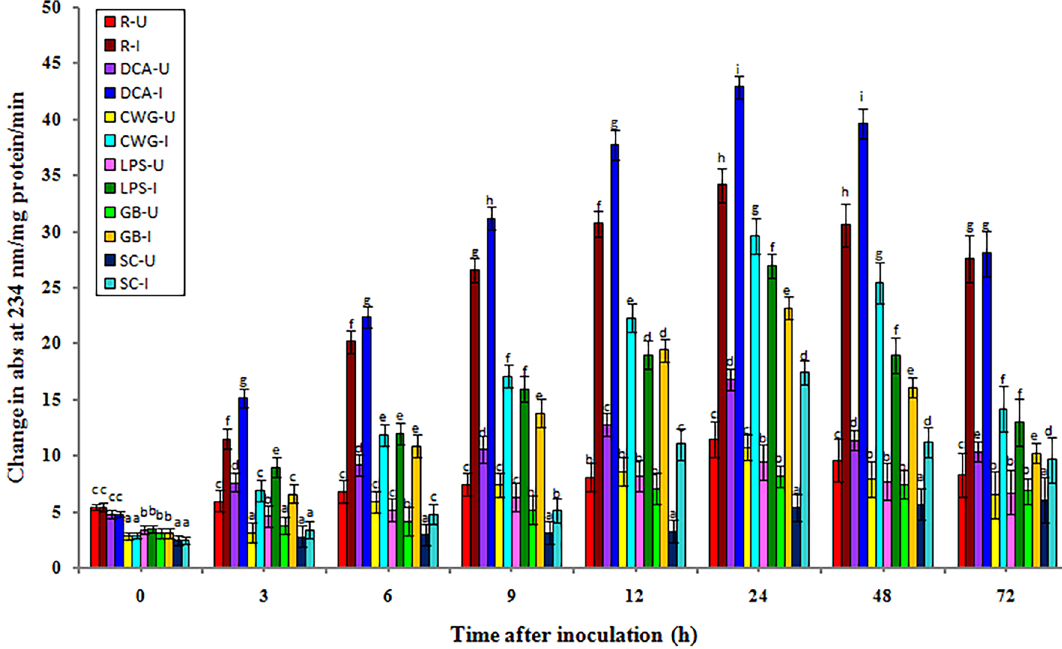
Figure 5. Temporal pattern of LOX activity in 2-day old P. glaucum seedlings with (I-inoculated) or without (U-uninoculated) Sclerospora graminicola inoculation. R—resistant, S—susceptible, DCA—3,5- Dichloroanthranilic acid treated, CWG—Cell Wall Glucans isolated from the endophyte Trichoderma hamatum UOM 13, LPS—Lipopolysaccharides isolated from bacteria Pseudomonas fluorescens UOM 14, GB— Glycinebetaine an amino acid derivative. Bars indicate standard errors; means with different superscripts are significantly different, as shown by Tukey’s HSD test ( p ≤ 17.42 units LOX activity. LOX activity at 24 hpi in DCA, CWG, LPS, and GB-treated seedlings was 2.4-, 1.7-, 1.55-, and 1.33-folds higher than that of the control seedlings, respectively. Resistant seedlings showed 34.18